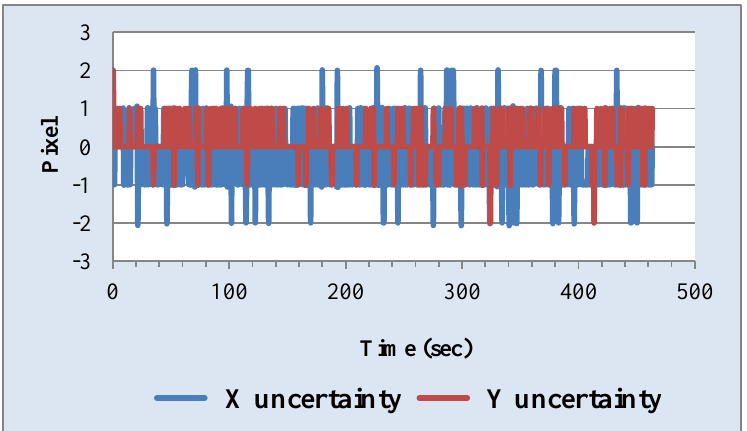
Figure 10. Sensing uncertainty of the Sun position sensor.